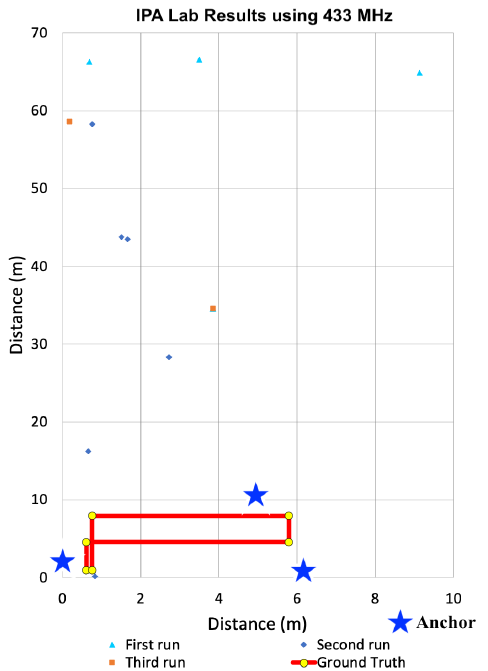
Figure 11. Position estimates obtained using RSS-based localization with 433 MHz transceivers in an engineering lab at the University. Reference anchor locations used for localization are shown as stars and the solid red line constitutes the ground truth path. The different colored points show the calculated positions while traversing the lab during multiple successive